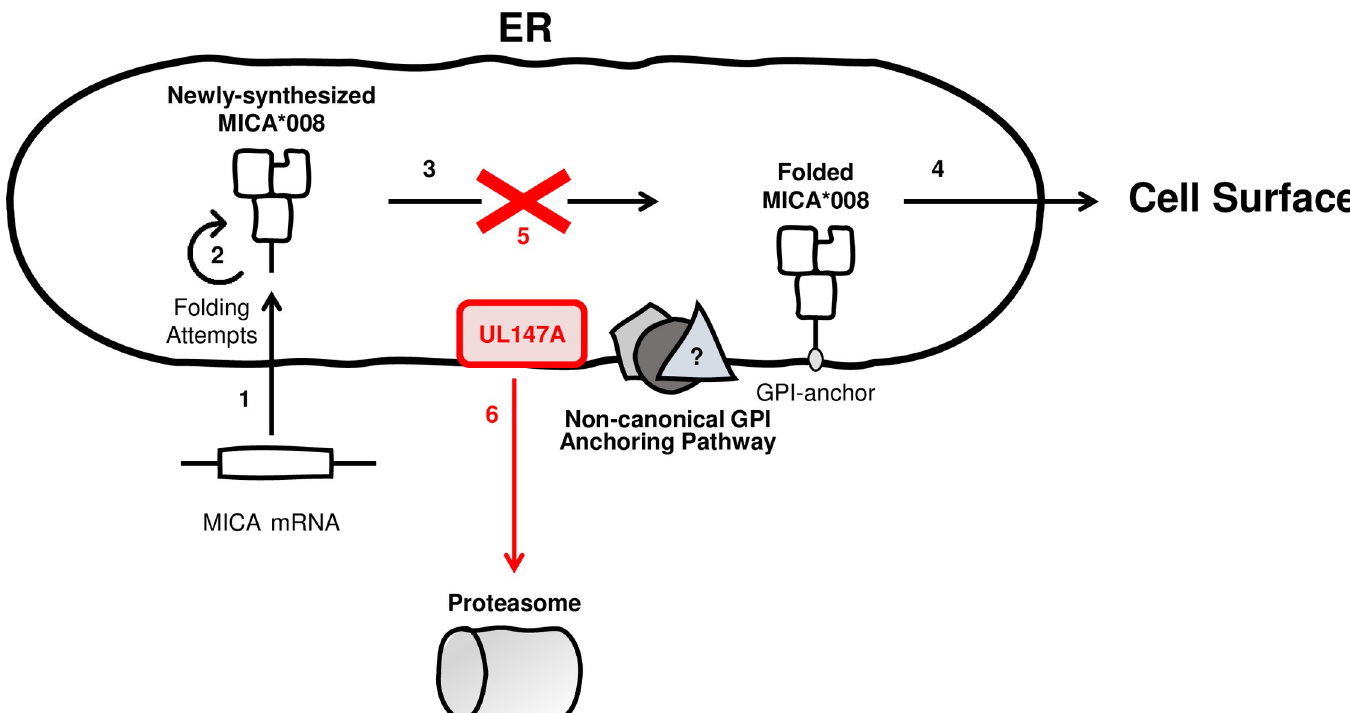
Fig 8. Model of UL147A Function. A model of UL147A’s effect on MICA � 008: (1) following HCMV infection, MICA � 008 mRNA is upregulated and the protein is translated into the ER lumen. (2) The immature, non-anchored form of MICA � 008 is retained for repeated folding attempts. (3) MICA � 008 undergoes GPI anchoring via an unknown non-canonical pathway and (4) subsequently reaches the cell surface. (5) UL147A targets this stage, inhibiting MICA � 008 maturation. This is the main effect during HCMV infection. Some non-anchored MICA � 008 is subsequently diverted to the cytosol, (6) where it is degraded by the proteasome. Viral mechanisms are marked in